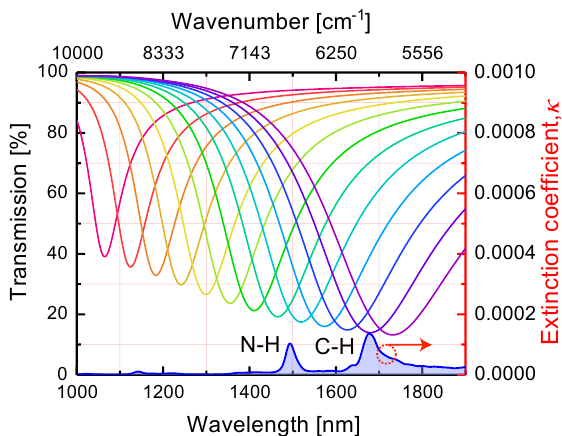
Figure 3. Calculated transmission spectra of gold metasurfaces with NPs of lengths L varied from 100 (crimson curve) to 220 (purple curve) nm in 10 nm steps, whereas lattice periods were fixed at Λ Λ 2 = 200 nm. The extinction coefficient of NMA is shown below the transmission 1 = 400 nm and curves. The gold metasurface was embedded in NMA with a thickness of 100